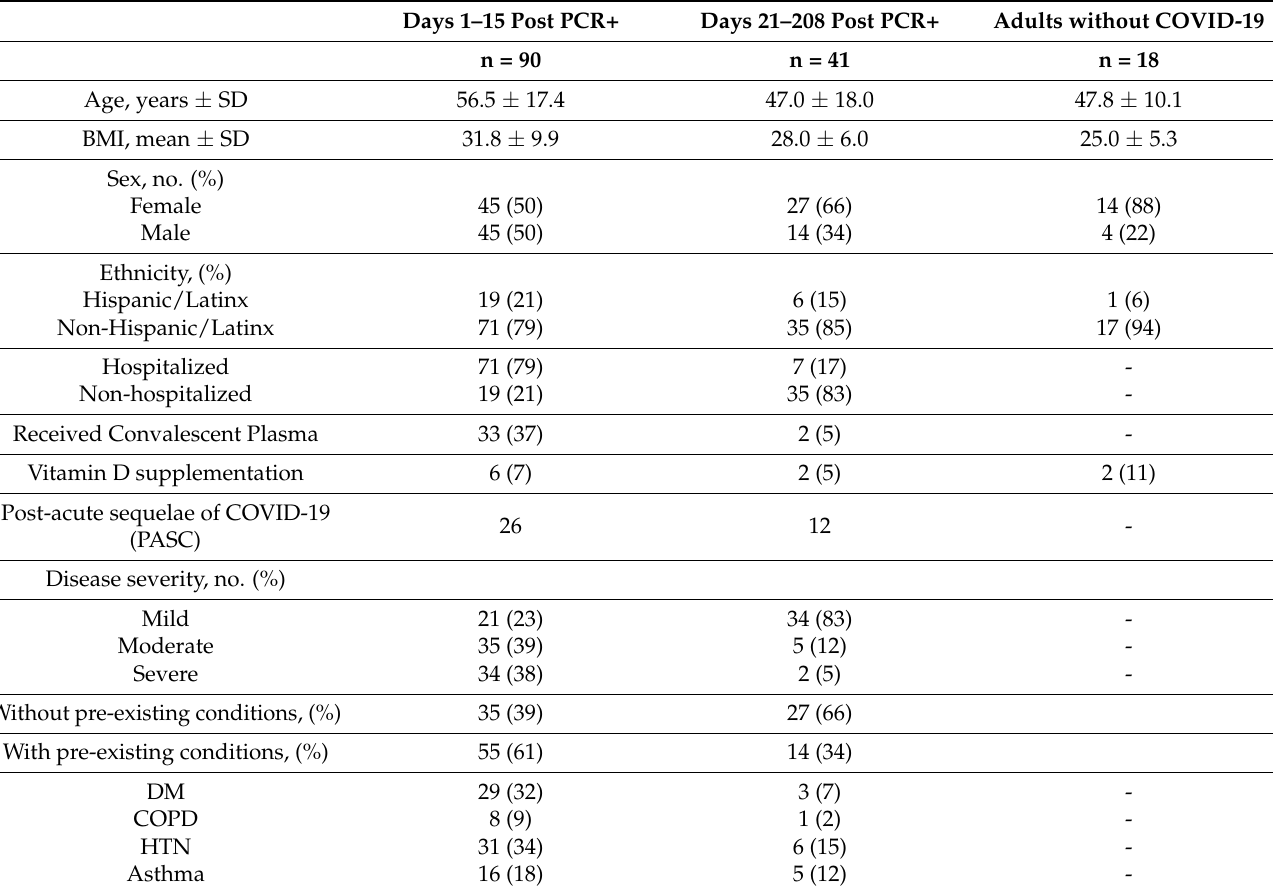
Table 1. Participant demographics for 25-hydroxyvitamin D (n =